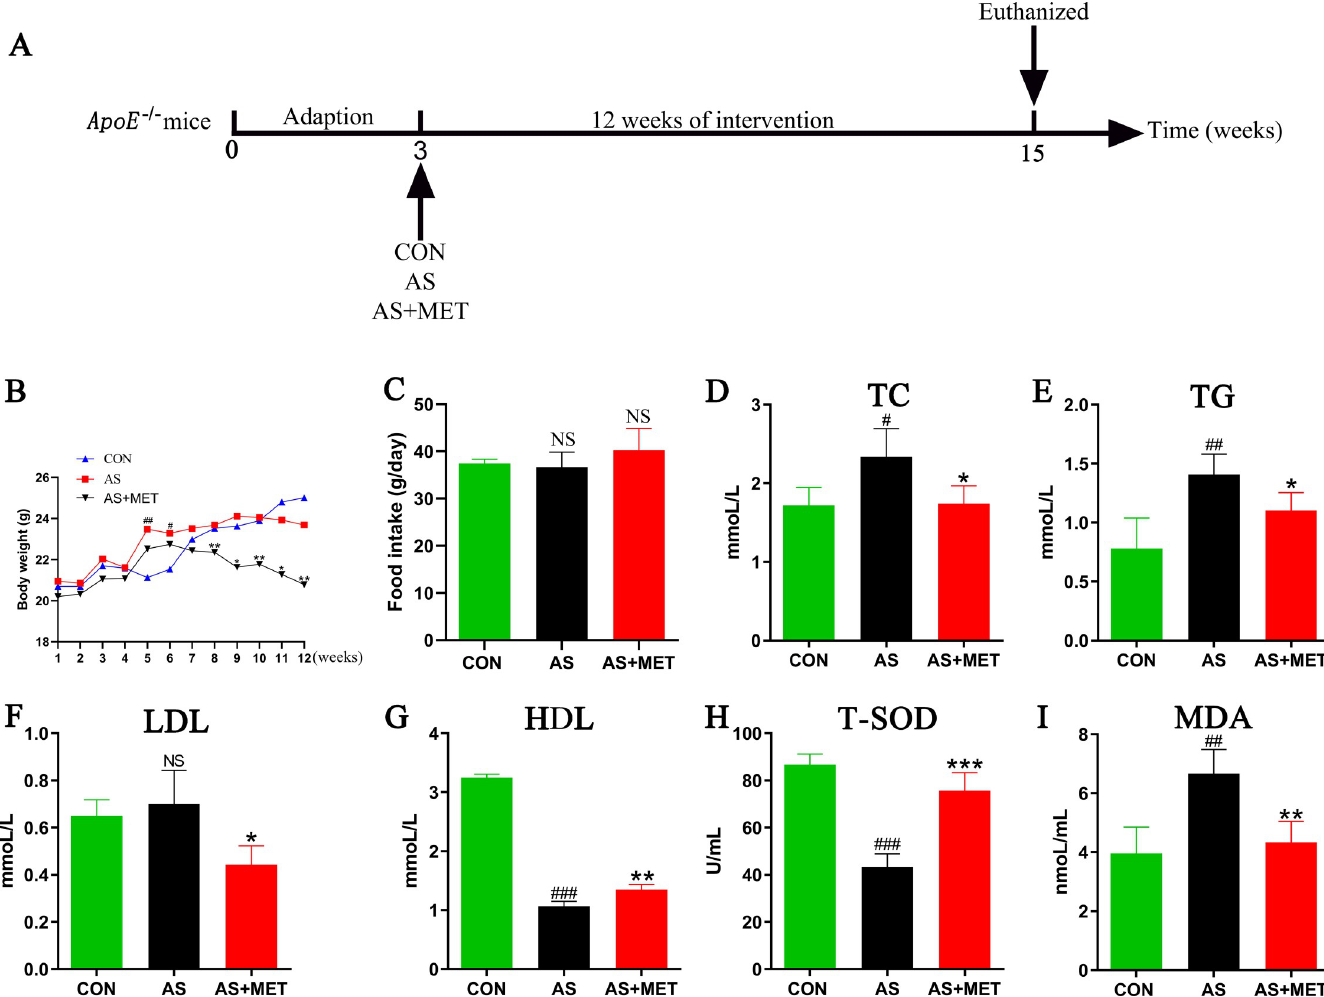
Fig 1. Effects of oral MET intervention on the parameters in AS. (A) Schematic diagram of the study. After 3 weeks of adaption feeding, ApoE -/- mice with 18-20g were randomly assigned into 3 groups: control group (CON), atherosclerosis group (AS) and AS treated with metformin (MET) group (AS+MET). After 12 weeks of intervention, all of the mice were sacrificed and related indicators were investigated; (B) Body weights (BWs) dynamic curve; (C) BWs at the end of the experiment; (D) Total cholesterol (TC); (E) Triglyceride (TG); (F) High-density lipoprotein (HDL); (G) Low-density lipoprotein (LDL); (H) Total superoxide dismutase(T-SOD); (I) Malondialdehyde (MDA). Results were from 4 independent experiments were performed in triplicate. Data were presented as mean ± SEM. # (CON vs. AS): # p < 0.05, ## p < 0.01, ### p < 0.001. � (AS vs. AS+MET): � p < 0.05, �� p < 0.01, ��� p < 0.001. NS, no significant difference.